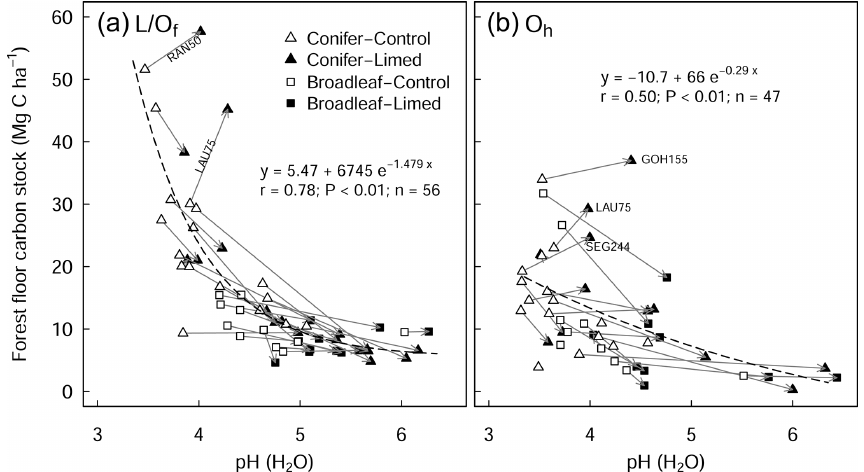
Figure 1. Relationship between the pH of the forest floor layer and the carbon stock of the (a) L/O f and (b) O h horizons. The arrows indicate the change from control to limed plots. Missing arrows ( in b) are because the O h horizon disappeared at those sites as a result of liming. The r is the Pearson correlation coefficients between observed and fitted values. RAN50 is Rantzau 50, LAU75 is Lauterberg 75, GOH155 is the Göhrde 155, and SEG 244 is the Segeberg 244 site.